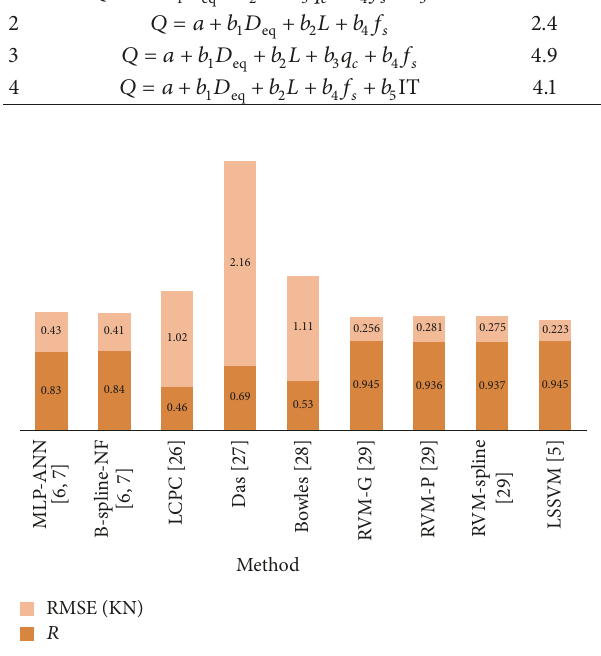
Figure 4: Correlation coefficient ( 𝑅 ) and RMSE for the predicted pullout capacity of previous studies.